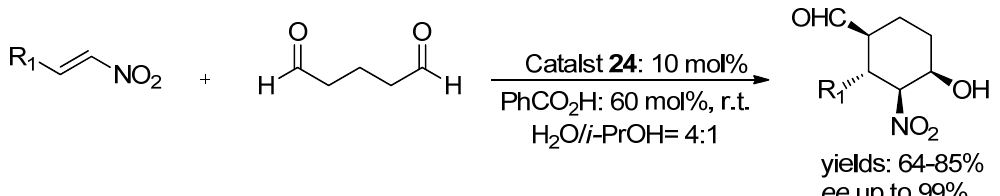
Scheme 9. Reaction of pentane-1,5-dial with nitroolefines catalyzed by 24 .